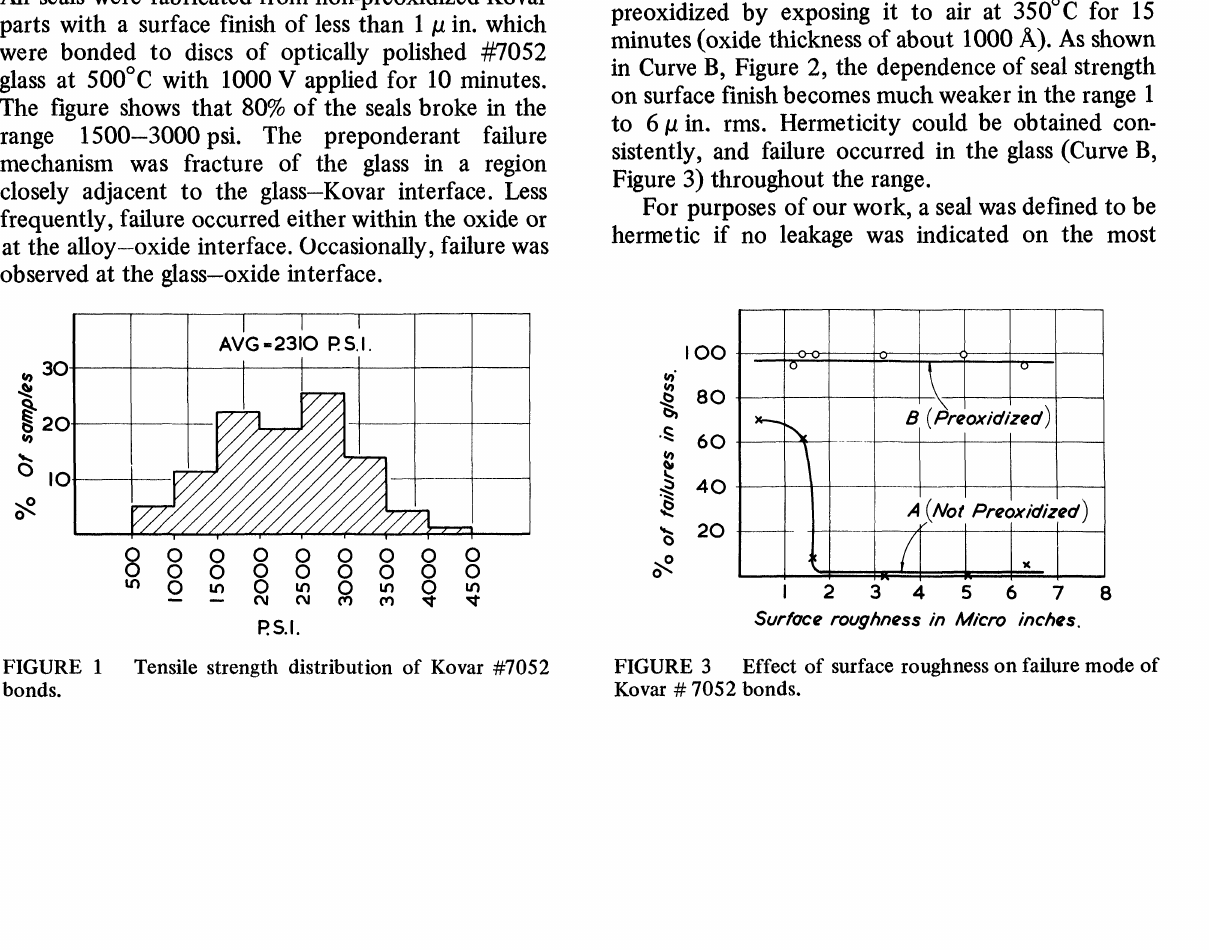
Tensile strength distribution of Kovar #7052 bonds.